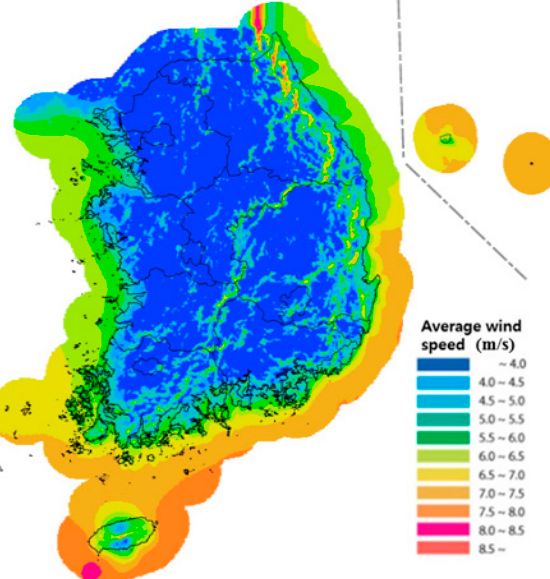
Figure 8. Average wind speed in South Korea [29].